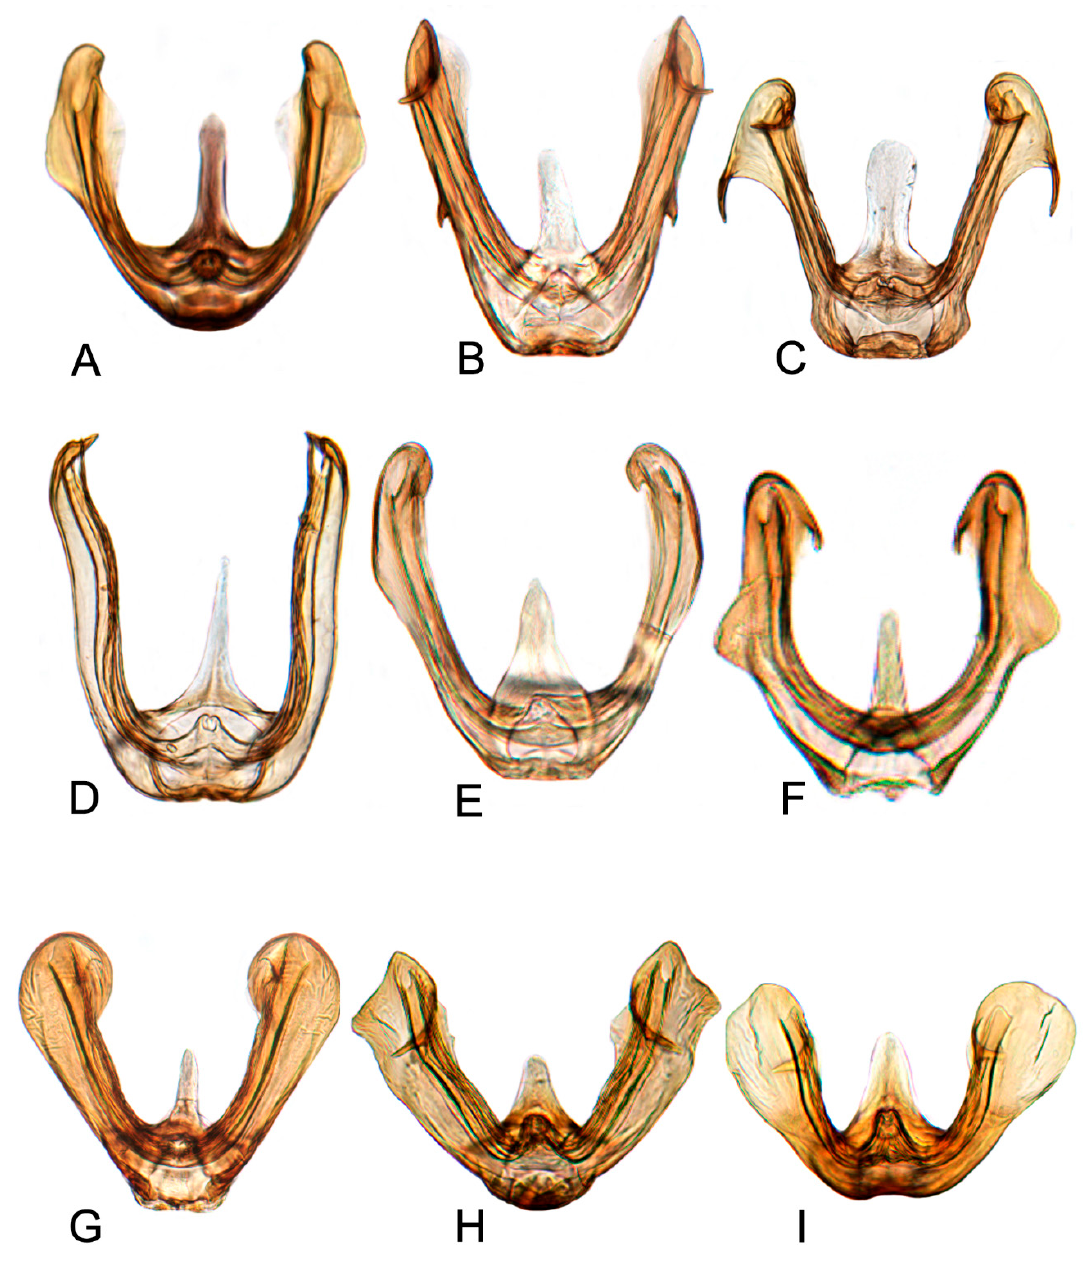
Figure 18. Aedeagus, posterior view. ( A ) H. expansivus ; ( B ) H. ventralis ; ( C ) H. hamuleus ; ( D ) H. yuanmouensis ; ( E ) H. hamatus ; ( F ) H. fuscomaculatus ; ( G ) H. lii ; ( H ) H. phycitis ; and ( I ) H. paraphycitis .